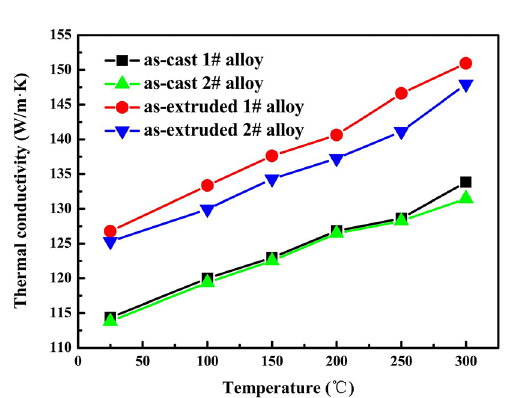
Figure 4. Temperature dependence of thermal conductivity of Mg- 1.5Zn-0.3Mn alloy (sample 1#) and Mg-2Zn-0.3Mn alloy (sample 2#) The results of Fig. 4 further reveal the difference of Mg-xZn-0.3Mn alloys in thermal conduction. Firstly, for the as-cast samples, the thermal conductivity of Mg-2Zn- 0.3Mn alloy is slightly lower than Mg-1.5Zn-0.3Mn